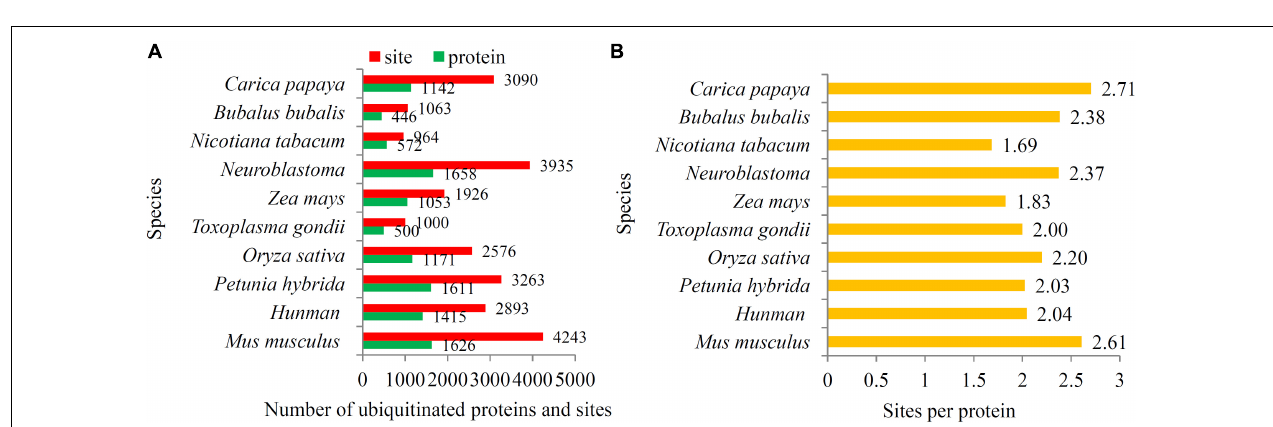
FIGURE 2 | The basic information of LC-MS/MS data. (A) Pearson’s correlation coefficient analysis of the data from different sample groups. The red color indicated positive correlation and green color indicated negative correlation. (B) The number of modification sites per protein. (C) The peptide mass error (ppm). (D) The protein mass [kDa]. The mass error threshold for peptide ions was set at 10 ppm, and the mass error threshold for protein was set at 0.02 Da.